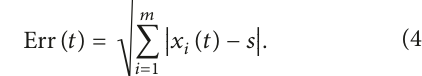
Figure 1: Dynamics of Err (𝑡) with different pinning algorithms. The left eigenvector index algorithm applies the strategy of pinning nodes associated with the largest elements in the left eigenvector corresponding to 0 of the Laplacian matrix. The pinned node number is fixed to be 3. Averaged over 50